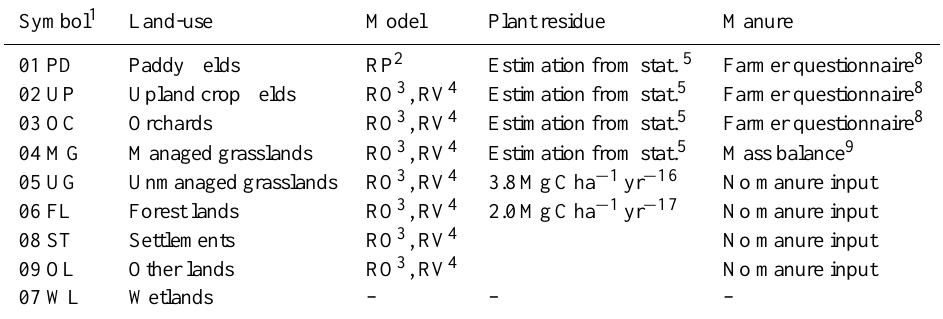
Table 1. Settings in simulation with regard to model version and data source used to determine rate of organic carbon input to soils for plant residue and manure in different land-use